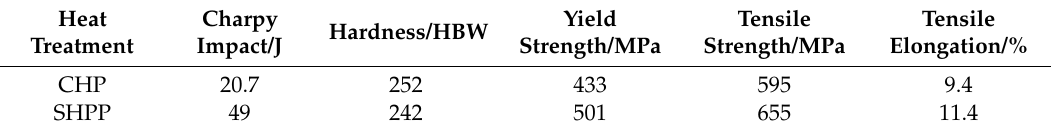
Table 2. Mechanical properties of experimental